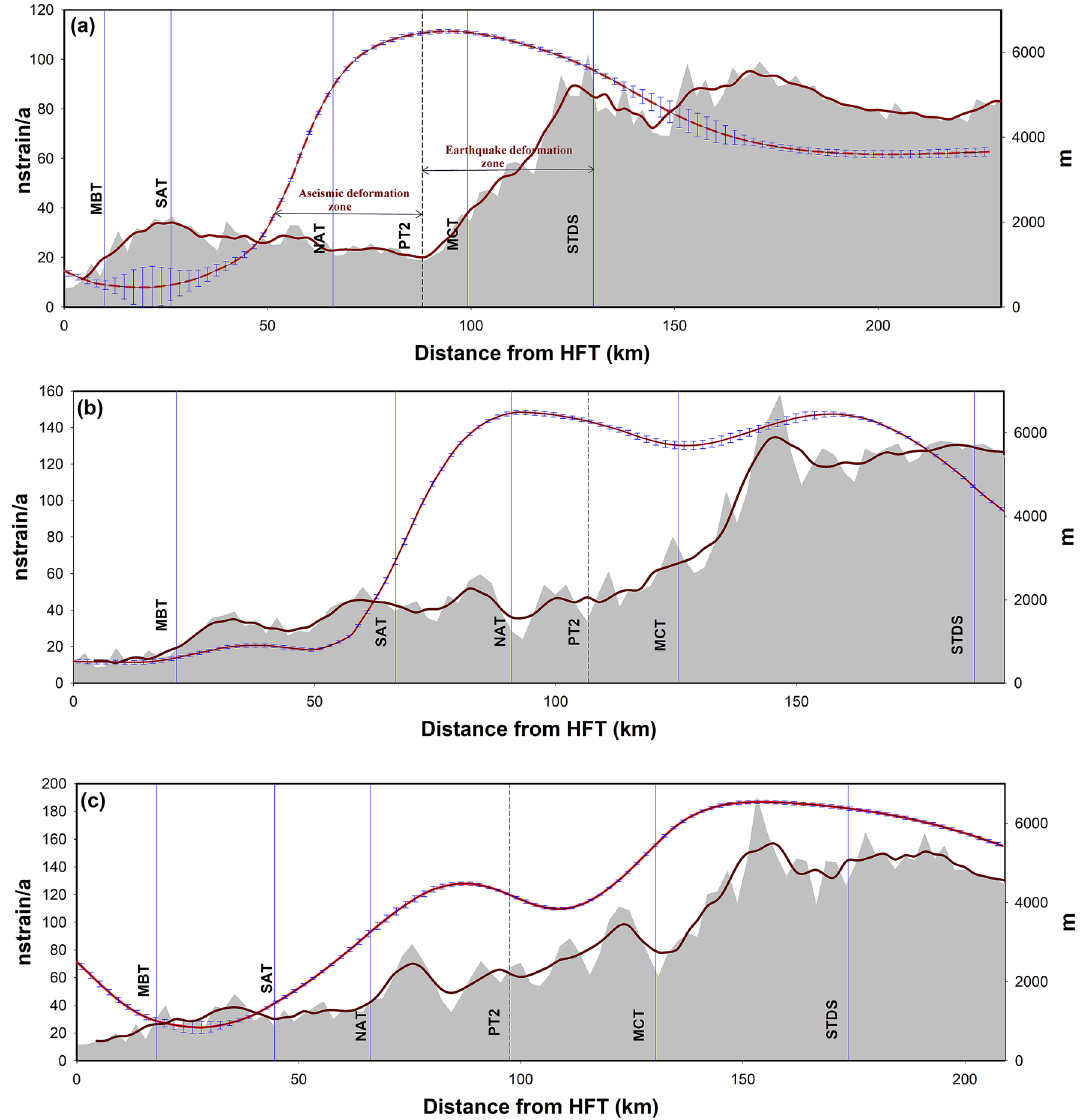
Figure 5. Strain-rate Vs Topography across three profiles. ( a ) across Nainital-Almora in LSZ, ( b ) Ramganaga- Baijro in LSZ and ( c ) Ramnagar-Badrinath begins from EDZ. The red lines with error bars indicate the strain rates and their uncertainties along the profiles. The grey areas represent the elevations and brown lines show the mean elevations along the earthquake of 1999. Thus it is imperative to know how the strain adjustment of local and other thrust systems around the Chamoli cluster could contribute to larger earthquakes and clustered seismicity. Strain-rate analysis in and around the Chamoli region shows an interesting curvilinear pattern (Encircled by violet dots in Fig. 3). Here the deformation field starts from Baijro in the Inner Lesser Himalaya at the western edge of Almora Klippe, where the TT terminates. The NE trending compressional strain vectors surpass the NAT and converge towards the Chamoli earthquake cluster. As mentioned earlier, in terms of crustal scale, the overall accommodation rate between the Lesser and the Higher Himalayas is asymmetric in the Garhwal and the Kumaun region, which is 7.38 ± 0.24 mm/a and 5.41 ± 0.55 mm/a respectively. Apart from the crustal-scale accommodation process of MHT, the contribution of local thrust systems toward modulating the Chamoli strain pattern also has to be considered. The linear crustal accommodation rate across the TT in the Garhwal Himalaya is 1.30 ± 1.22 mm/a (Table 2), while the same is 2.12 ± 0.55 mm/a across the Almora Klippe at the eastern Kumaun region. Similarly, across the NAT and the SAT the accommodation rates are 0.68 ± 0.65 mm/a and 1.44 ± 0.48 mm/a respectively. However, larger linear crustal accommodation rate (2.64 ± 1.66 mm/a) is taking place at the western edge of the Almora Klippe between Baijro and Chamoli. Extended level of seismicity from MCT towards Baijro and greater deformation in this region suggest that the local thrusts (NAT and SAT) are asymptotically connected to the gently dipping MHT as compared to the eastern part of the Almora Klippe 30,50 (Fig. 6). This observed asymmetry in the crustal accommodation processes over